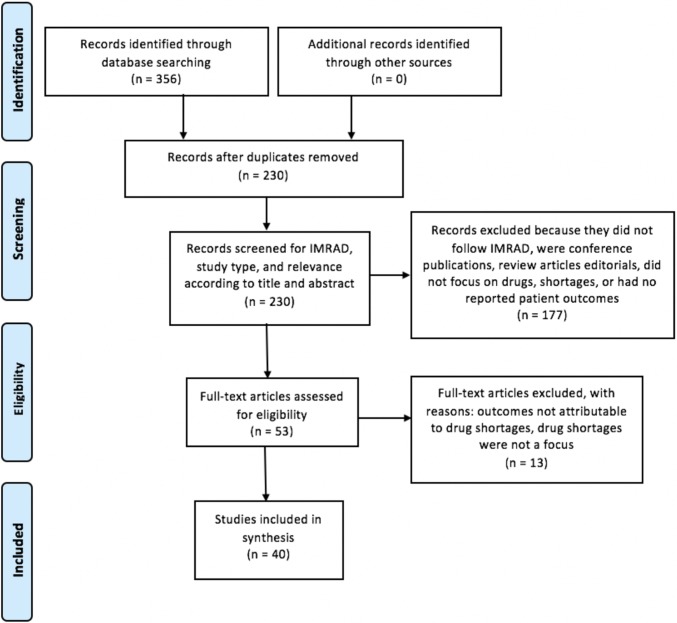
PRISMA flowchart.